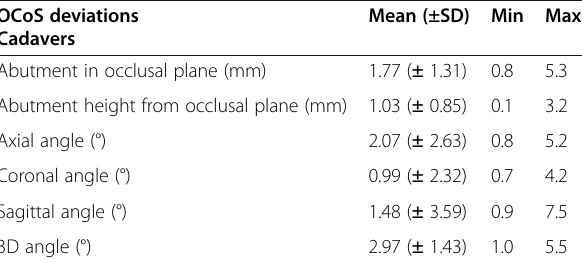
Table 2 Accuracy data. Result of the post-op